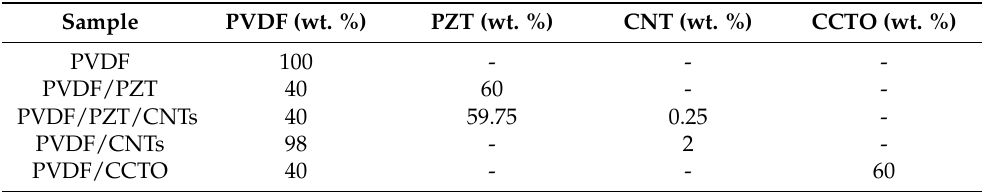
Figure 1. ( a ) Flexibility demonstration of a hot-pressed thin sample. ( b ) Schematic of corona poling with dipole orientation before ( c ) and after ( d ) poling. Table 1. PVDF polymer with different micro- and nano-fillers ratio used in the nanocomposite process. DMSO solvent content was same for all combinations (30 wt.